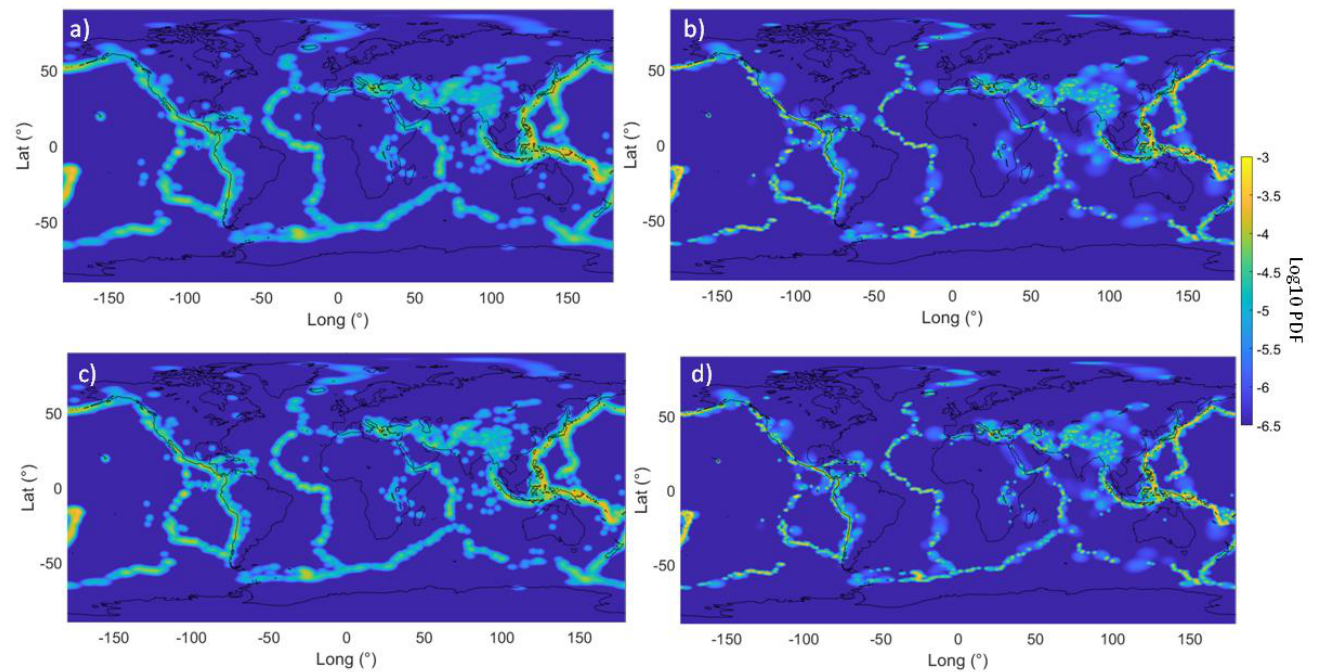
Figure 4. Spatially smoothed seismicity models using ( a ) 135 km smoothing distance from the fixed and ( b ) the nearest neighbor number NN = 1 from the adaptive smoothing seismicity approaches; spatially smoothed seismicity-corrected models using ( c ) 115 km smoothing distance from the fixed and ( d ) the nearest neighbor number NN = 1 from the adaptive smoothing seismicity approaches, employing the epicenters of the earthquakes for M w ≥ 5.5 in the global CMT catalog (normalized seismicity rates, i.e., PDF, are in log10 scale). Table 3. Log-likelihood ( LL ) values for the smoothed seismicity models for testing catalog from